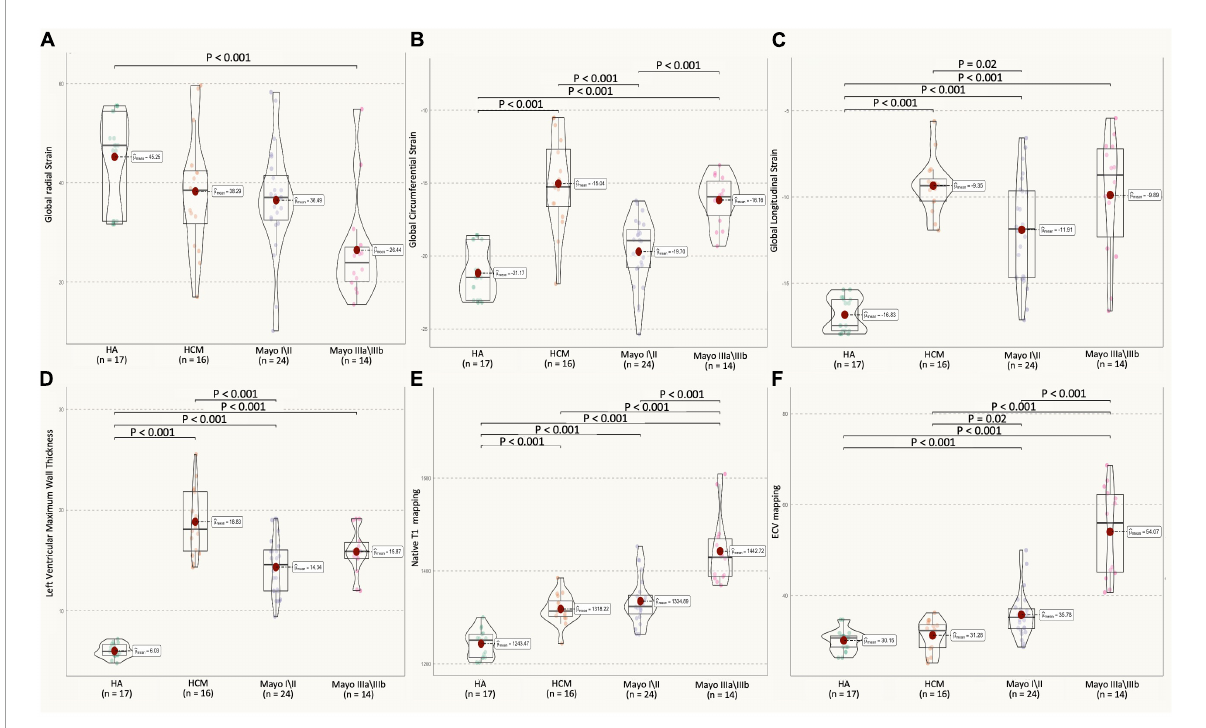
FIGURE4 Multiparameter CMR (GRS, GCS, GLS of left ventricular, LVMT, native Tl, ECV values) in HA, HCM, AL amyloidosis patients with different Mayo stages. (A) AL CA patients showed a decrease in LV GRS strain (H: 45.2 ± 9.4%, HCM: 38.3 ± 12.0%, M I/II: 36.5 ± 10.9%, M III: 26.4 ± 10.7%; H vs. Mayo III, P < 0.001) as compared to healthy controls. (B) AL CA patients showed an increase in LV GCS strain (H: –21.2 ± 1.8%, HCM: –15.0 ± 3.2%, M I/II: –19.0 ± 3.6%, M III: –16.2 ± 1.7, HCM vs. M I/II, M I/II vs. M III, P = 0.02), as compared between them. (C) Mayo stage I/II AL patients showed an increase in the absolute value of LV GLS strain (H: –16.8 ± 1.2%, HCM: –9.5 ± 1.8%, M I/II: –11.9 ± 3.0%, M III: –9.9 ± 3.5, HCM vs. M I/II, P = 0.02), as compared to HCM. (D) HCM patients showed an increase in LVMWT (H: 6.1 ± 0.7 mm, HCM: 18.8 ± 3.3 mm, M I/II: 14.3 ± 2.9 mm, M III: 15.9 ± 2.3 mm, HCM vs. M I/II, P < 0.001), as compared to Mayo I/II AL patients. (E) AL patients showed an increase in native Tl mapping (H: 1,243.5 ± 29.85 ms, HCM: 1,318.2 ± 32.4 ms, M I/II: 1,334.9 ± 49.9 ms, M III: 1,442.7 ± 74.9 ms, H vs. M I/II, HCM vs. M III, Mayo I/II vs. Mayo III, P < 0.001, respectively), as compared between them. (F) AL CA patients showed an increase in ECV mapping (H: 30.1 ± 2.5%, HCM: 31.3 ± 3.4%, M I/II: 37.8 ± 5.7%, M III: 54.1 ± 9.9%, H vs. M I/II, Mayo I/II vs. Mayo III, P < 0.001, respectively, HCM vs. M